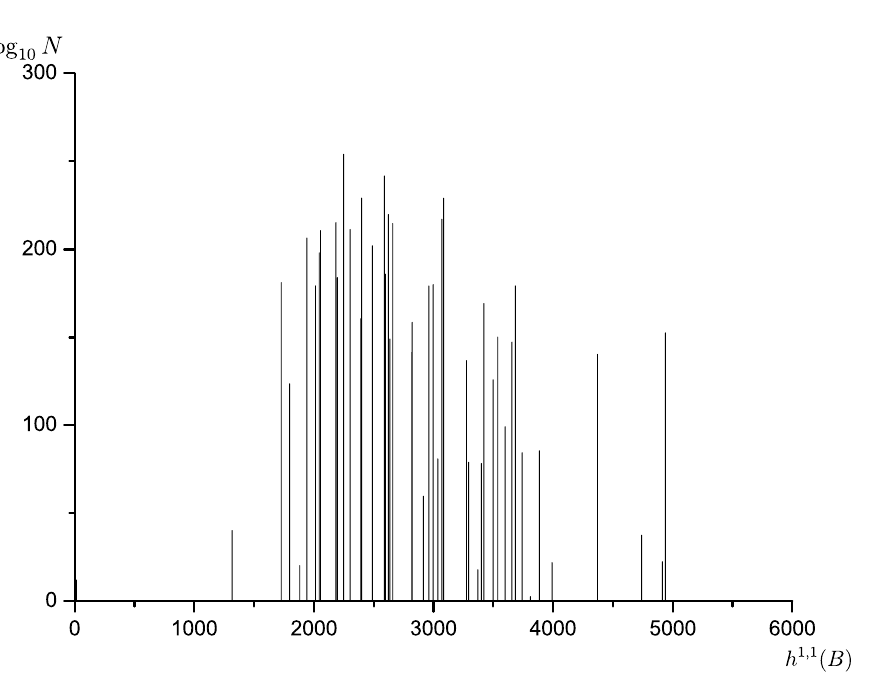
Figure 7 . Logarithm of the estimated number of good bases N good as function of h 1 ; 1 ( B ), from blowing up P 3 .